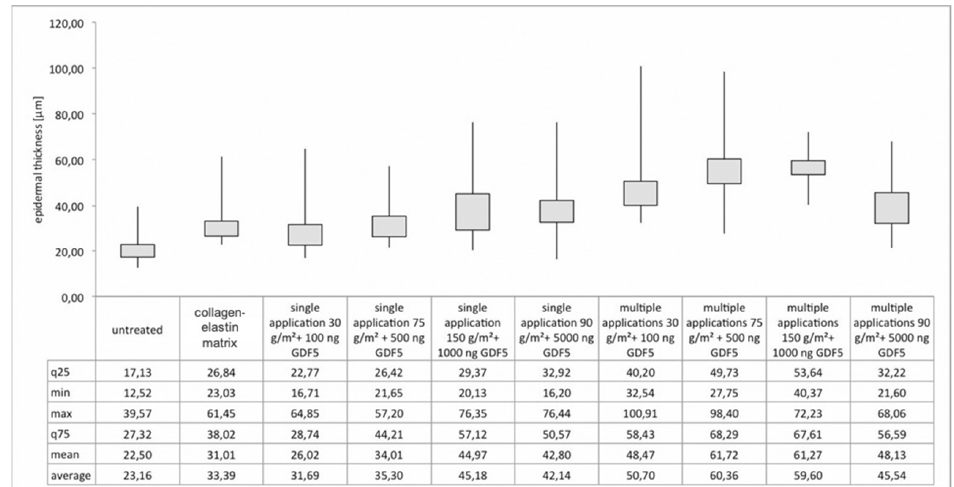
Figure 3. Histological analysis of the epidermal thickness. The epidermal thickness was histologically evaluated in micrometers by repetitive measurements from the stratum basale to the stratum corneum in three different sections per sample, with an interval of 100 µ